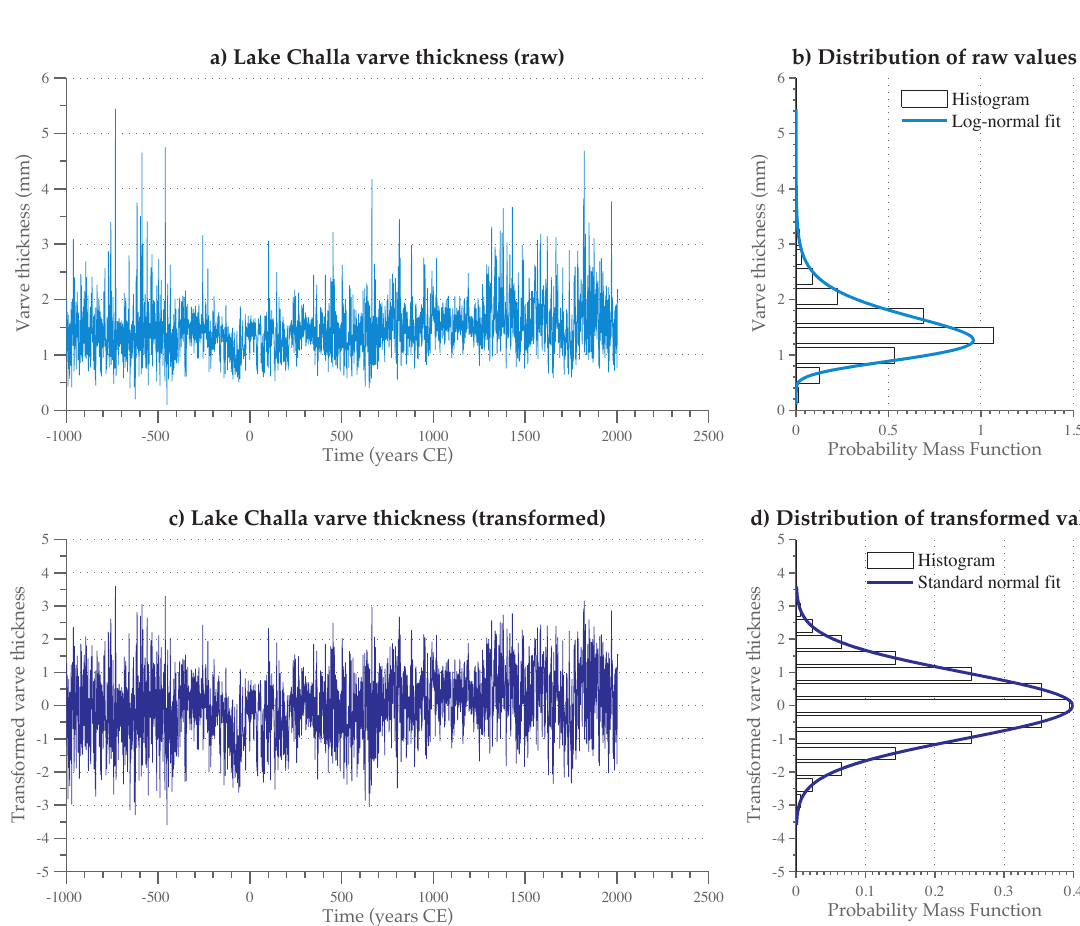
Figure 10. Raw and transformed time series of Lake Challa varve thickness (Wolff et al., 2011). (a) Raw time series, interpolated at yearly intervals; (b) empirical histogram (bars) and parametric fit to a log-normal distribution (cyan line); (c) transformed time series; (d) empirical histogram of the transformed time series (bars) and parametric fit to a standard normal (blue